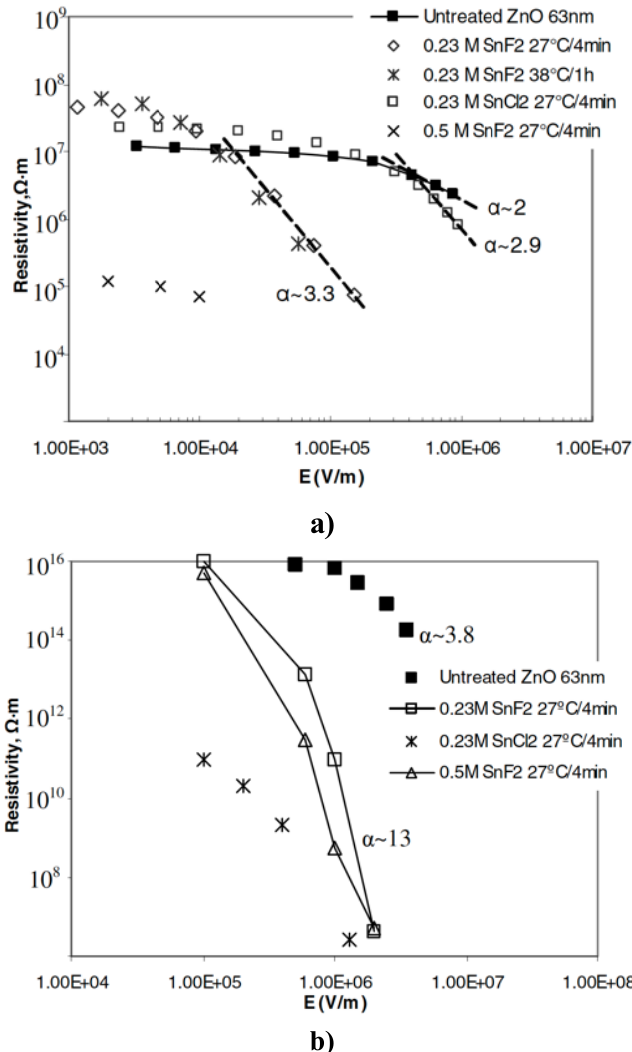
Figure 14. Resistivity versus electric field of ( a ) treated fillers and ( b ) 20 vol.% ZnO/EPDM nanocomposites. © 2021 IEEE. Reprinted, with permission, from [58].